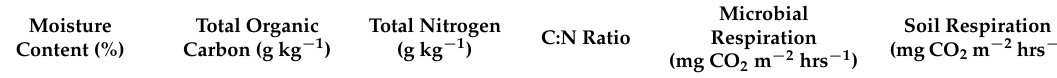
Table 4. Impact of the experimental site (ES), crop species (CS), sustainable agrobiotechnological practices (SAIs) on soil physico-chemical properties and soil sustainability indicators (microbial and soil